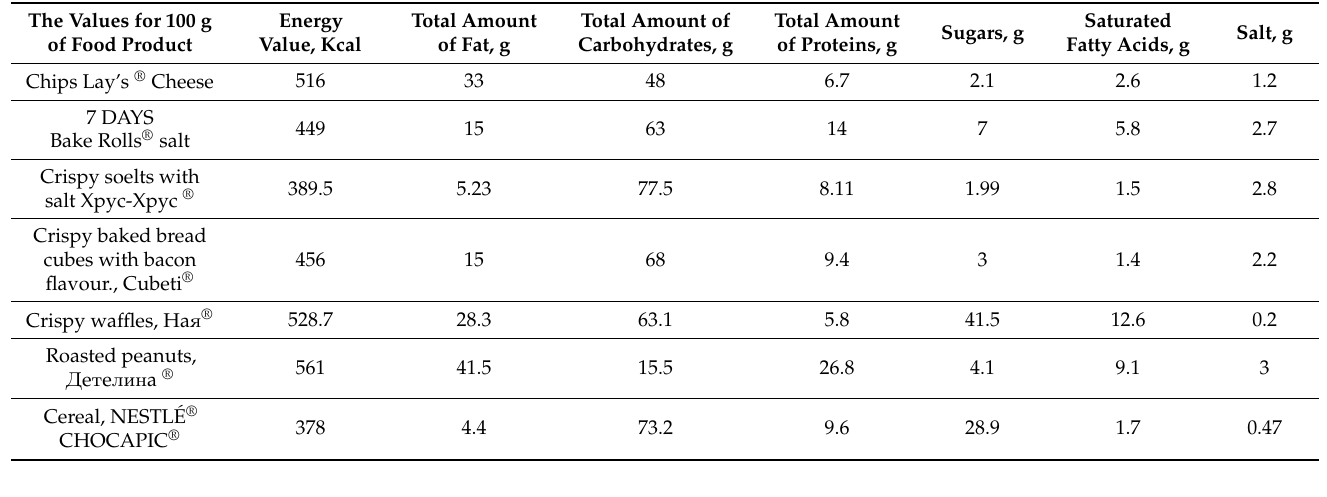
Table 1. Composition and nutritional value of the cafeteria diet.